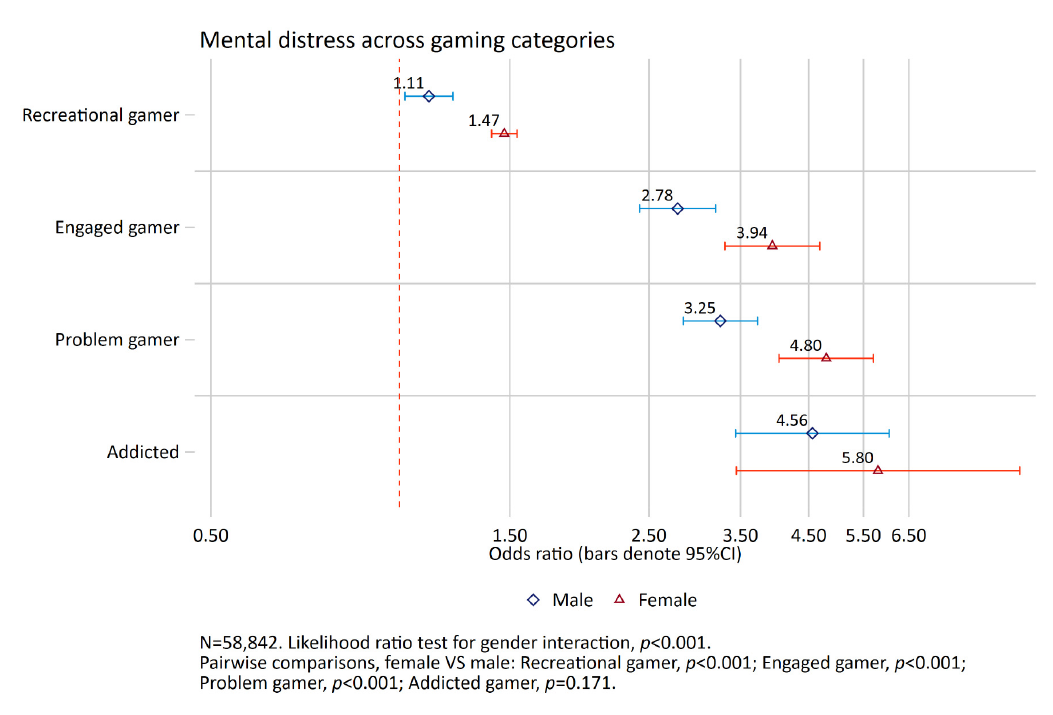
Figure 4. Association between gaming categories and mental distress. Results from logistic regres- sion analysis. Non-gamer as reference group. Adjusted for age, relationship status and living ar- rangements. The red dashed vertical line indicates odds ratio of 1 (no association). For higher life satisfaction, the odds ratio for problem gamers was 0.31 for males compared to 0.30 for females, while the corresponding estimates for addicted gamers were 0.23 and 0.20 (Figure 5).